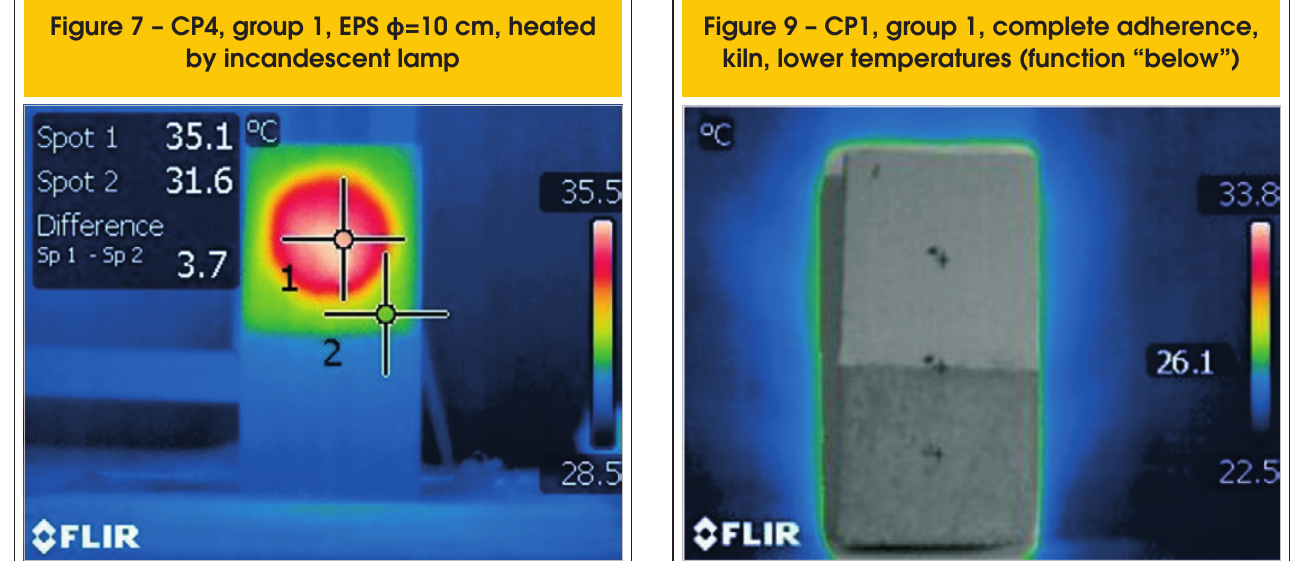
Figure 9 – CP1, group 1, complete adherence, kiln, lower temperatures (function